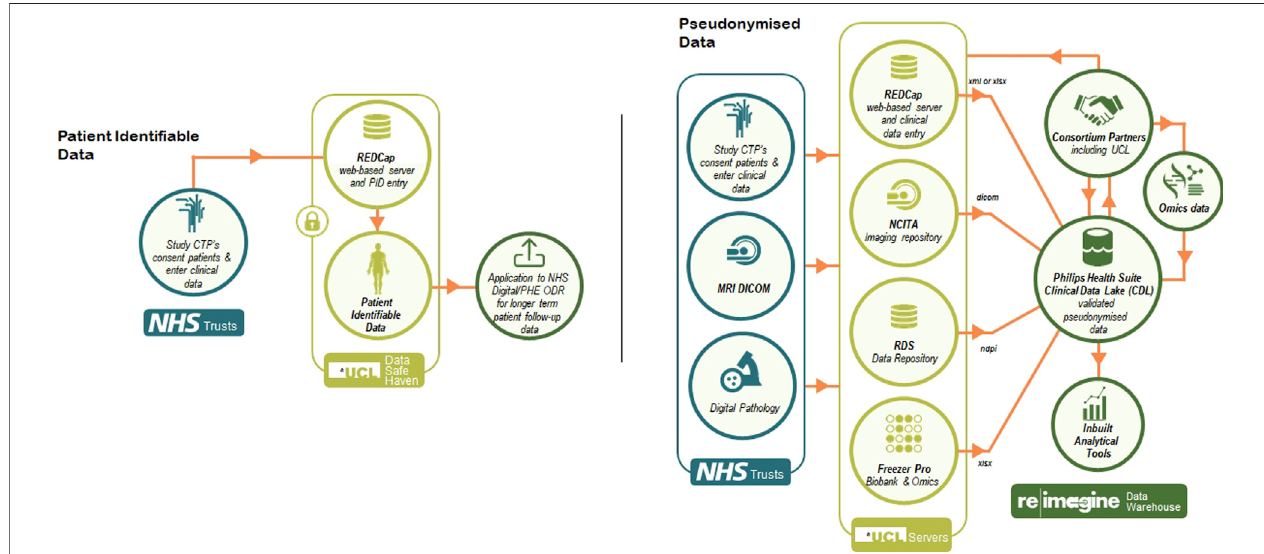
FIGURE 1 | The ReIMAGINE data management